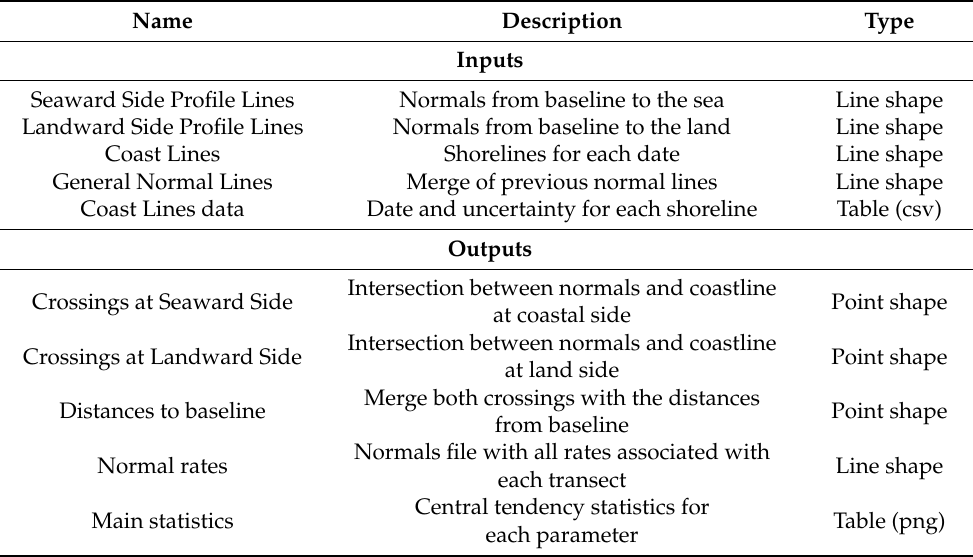
Table 3. Summary of input and output data for the whole ODSAS approach: name, brief description, and